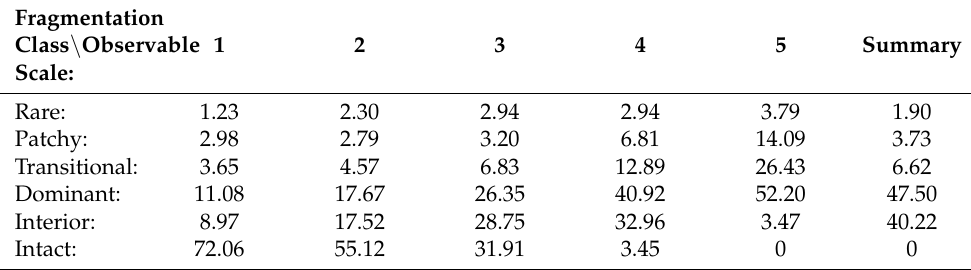
Table 7. Summary of observable scale for fragmentation analysis in the year 2000.